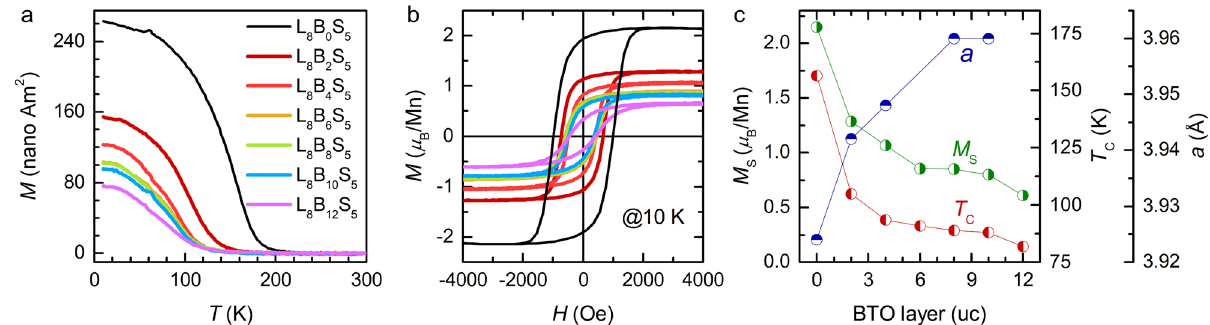
Fig. 5 Strain effects on the magnetism. a , b Temperature dependent magnetization curves and magnetic hysteresis loops at 10 K measured for LMO/BTO/STO SLs with varied layer thickness of BTO. c Plots of M S , T C and in-plane lattice parameter ( a ) as a function of the layer number of